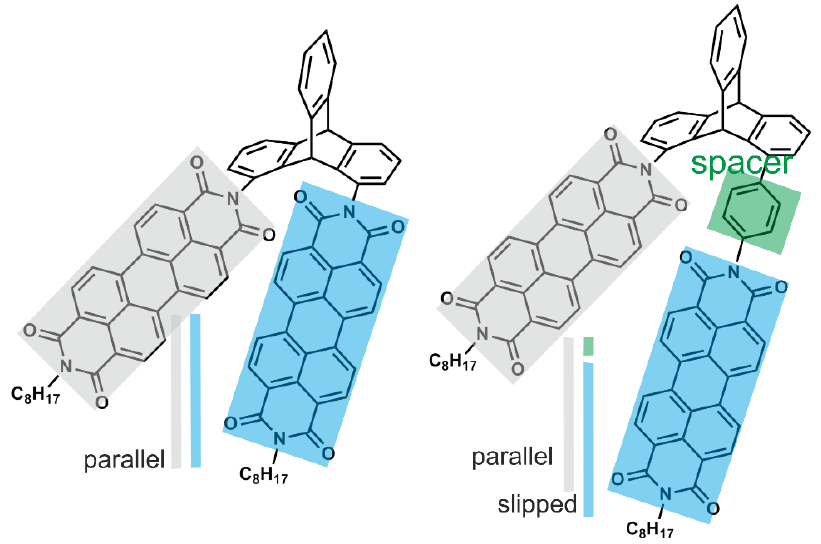
Figure 7. Triptycene utilized as a spacer between two π–π stacking chromophores